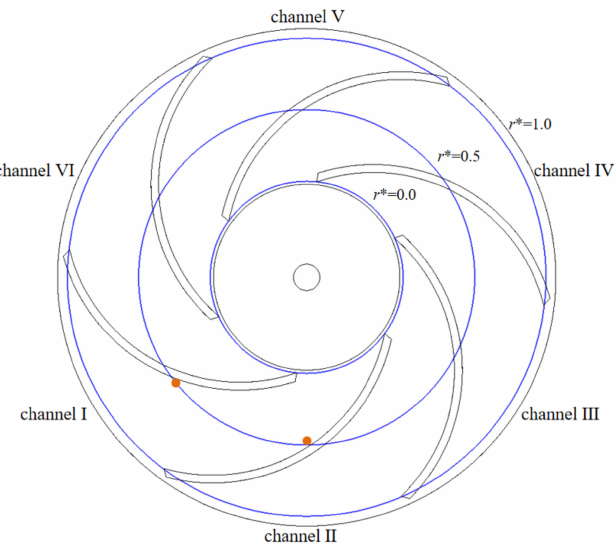
Figure 6. Definitions of radial cross-sections at r* = 0.0, 0.5 and